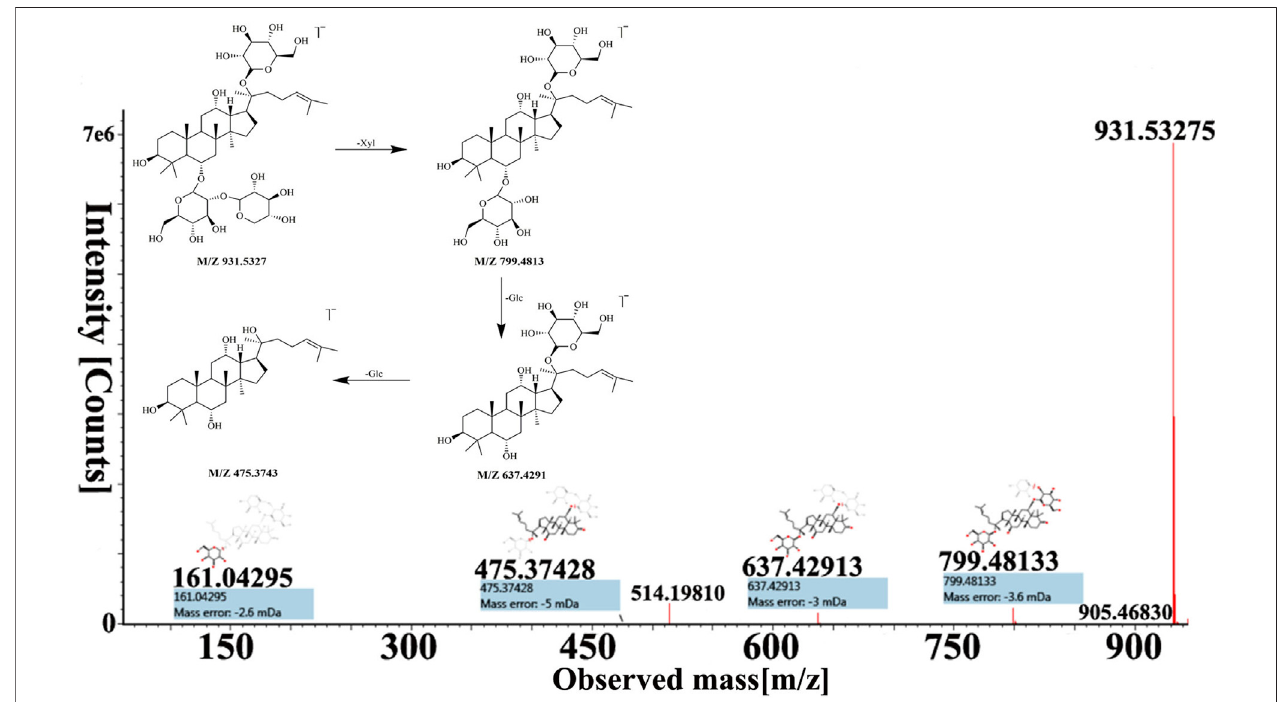
FIGURE 3 | The MS spectra and fragmentation pattern of notoginsenoside R 1 in negative ion